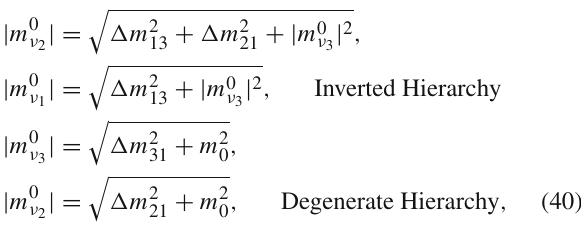
Fig. 2 From left to right: the atmospheric angle versus a the reactor angle, b m 0 and | (cid:17) | , and c m ee versus m 0 and | (cid:17) | . Degenerate hierarchy: blue and green points stand for m 0 and | (cid:17) | , respectively. The dot-dashed, dashed and thick lines stand for 1 σ , 2 σ and 3 σ of